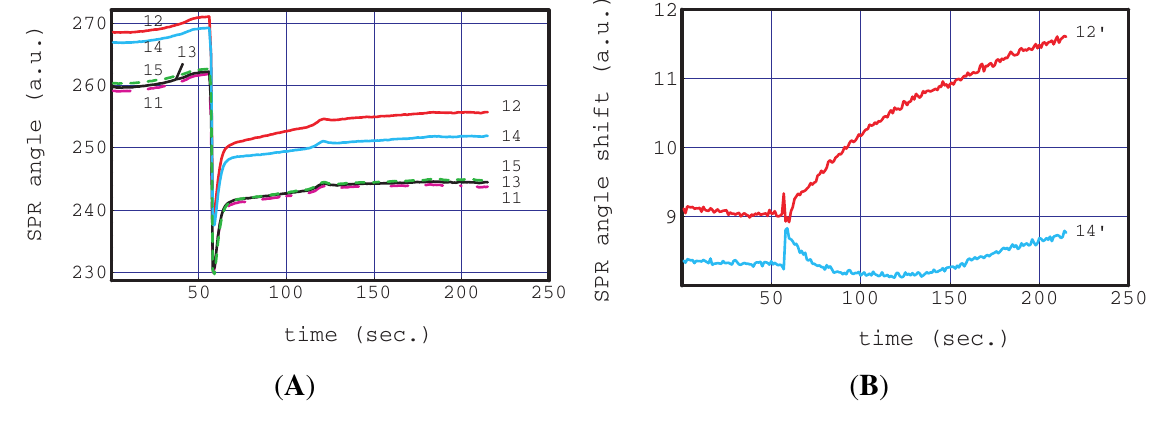
antigen: anti human IgG (12:I3382), the non-specific antibody of the target antigen: anti Staphylococcal alpha Hemolysin (14:S5V156-754), and their references on both sides.